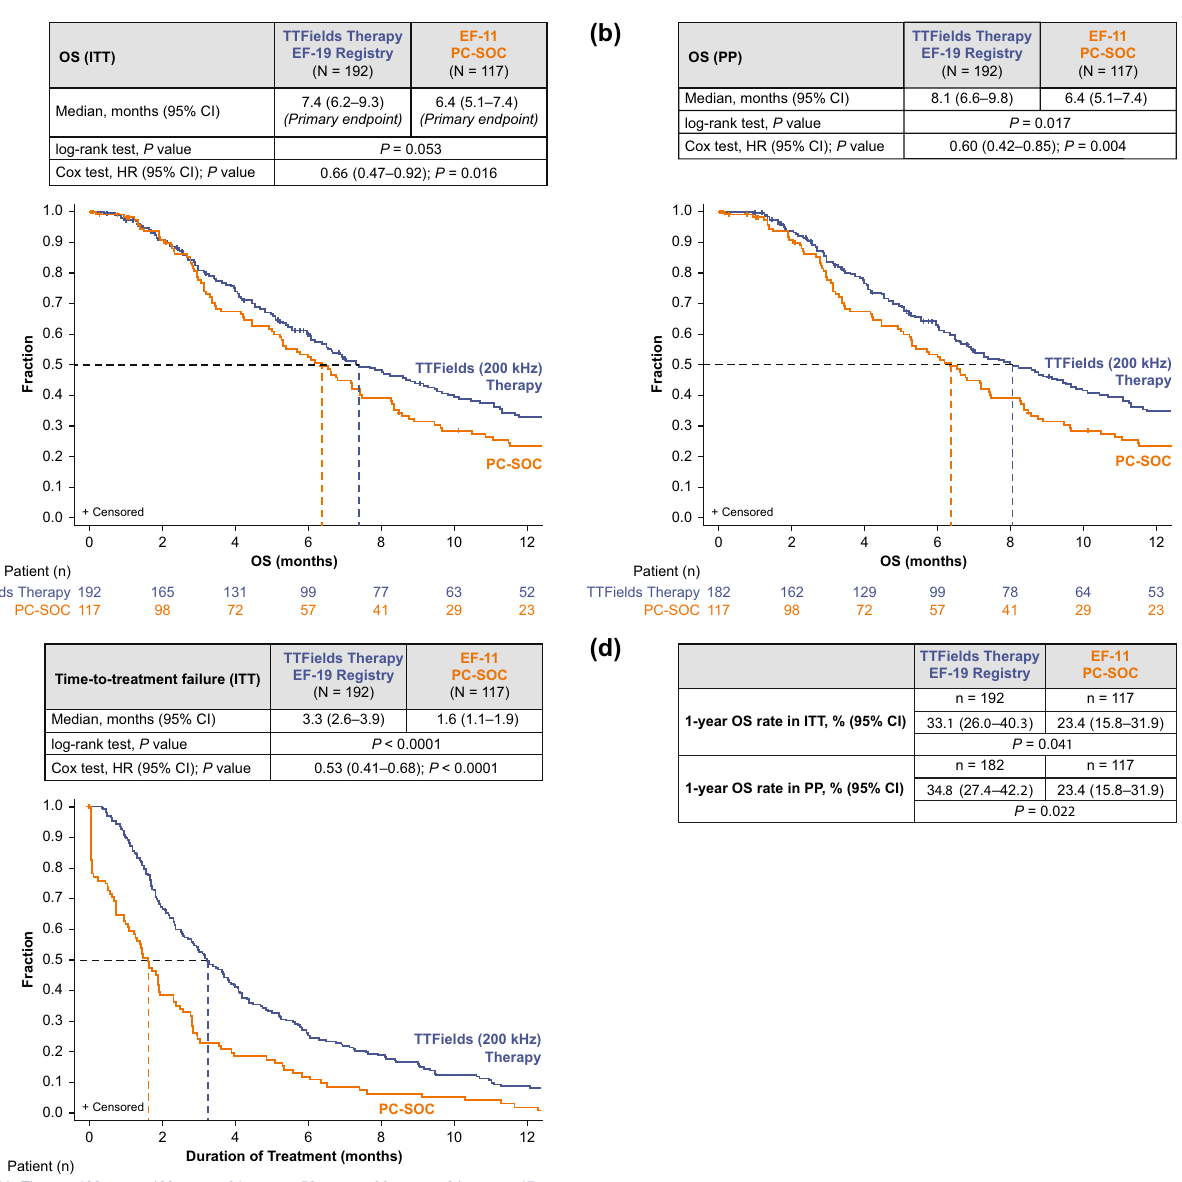
Fig. 1 Kaplan–Meier curve comparing TTFields (200 kHz) therapy from EF-19 registry and PC-SOC patients with rGBM for a OS in ITT popula- tions (primary endpoint), b OS in PP populations, c time to treatment failure in ITT populations, and d 1-year OS rates in ITT and PP popula- tions. CI, confidence interval; HR, hazard ratio; ITT, intent-to-treat; OS, overall survival; PC-SOC, physicians’ choice standard of care; PP, per protocol; rGBM, recurrent glioblastoma; TTFields, Tumor Treating